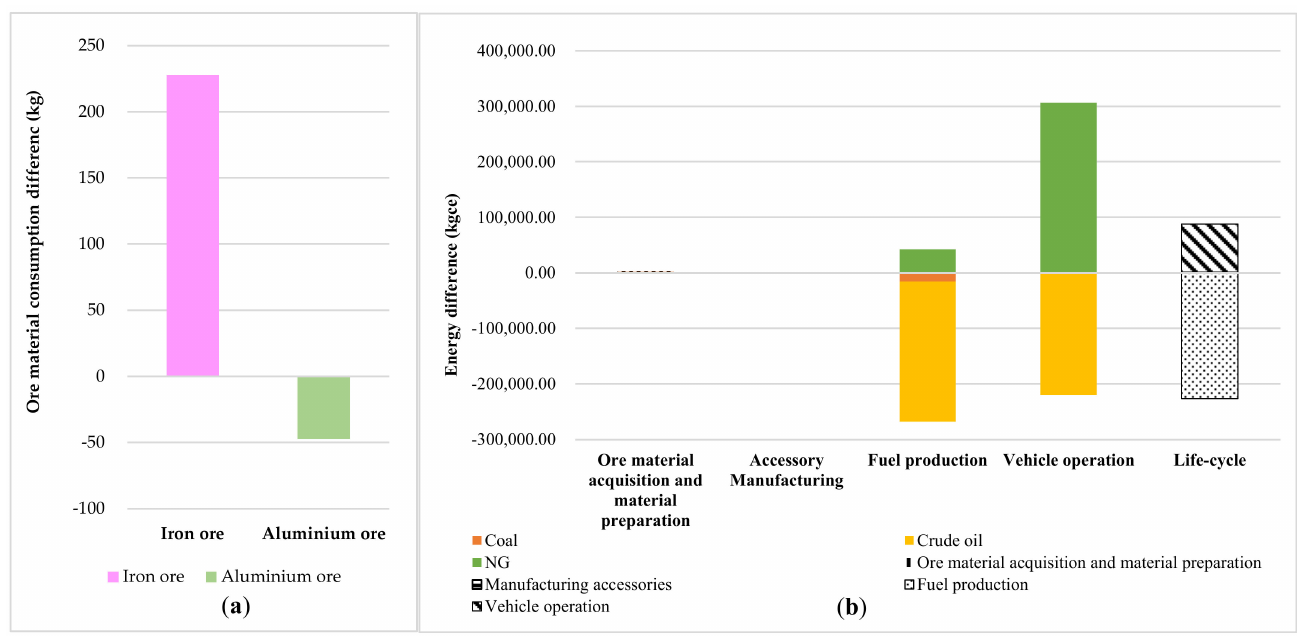
Figure 3. Resource consumption of the LNG tractor-trailer compared to the diesel tractor-trailer: ( a ) ore material; ( b ) energy.